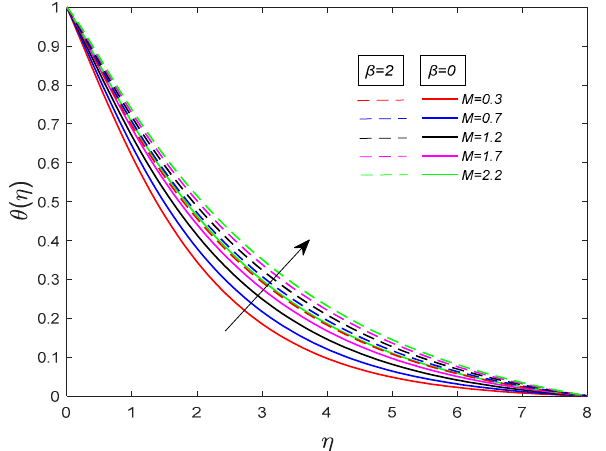
Figure 3. Effect of magnetic parameter (M) on axial velocity profile with Pr = Sc = 0.7, Ec = Kr = Sr = 0.1.